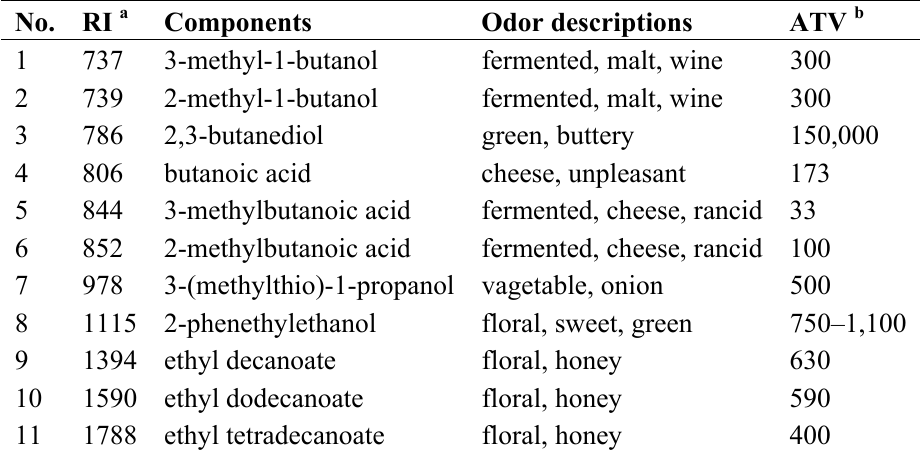
Table 1. Odor-active compounds in makgeolii